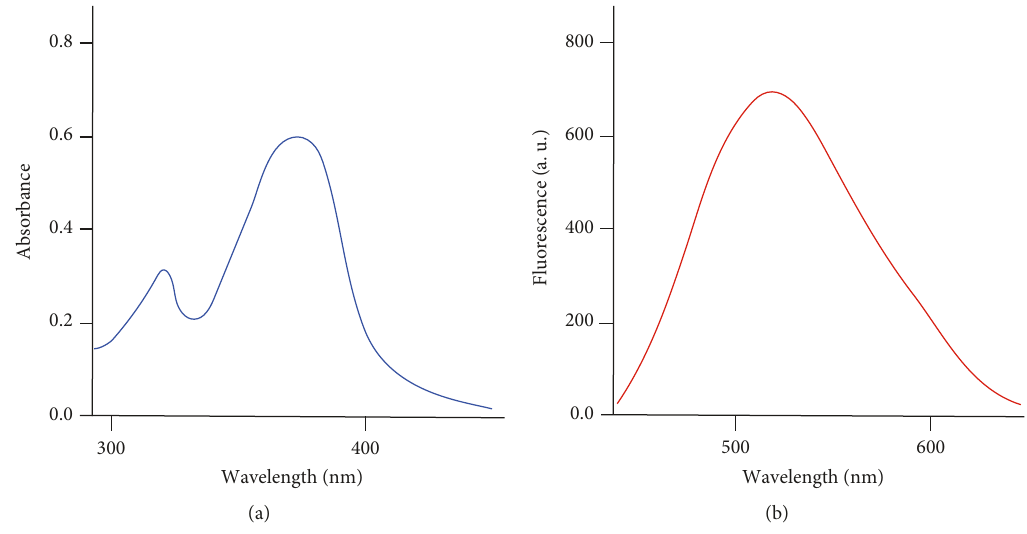
Figure 1: Electronic spectra of 4 in acetonitrile ( 2 2 · 10 − 5 М ): (a) absorption and (b) emission ( λ